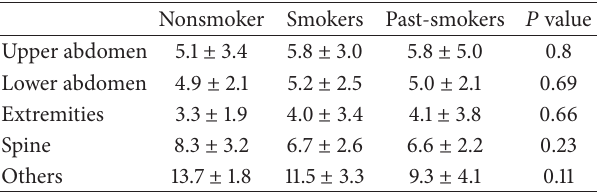
Table 3: Surgical duration hour in different surgical areas between three male